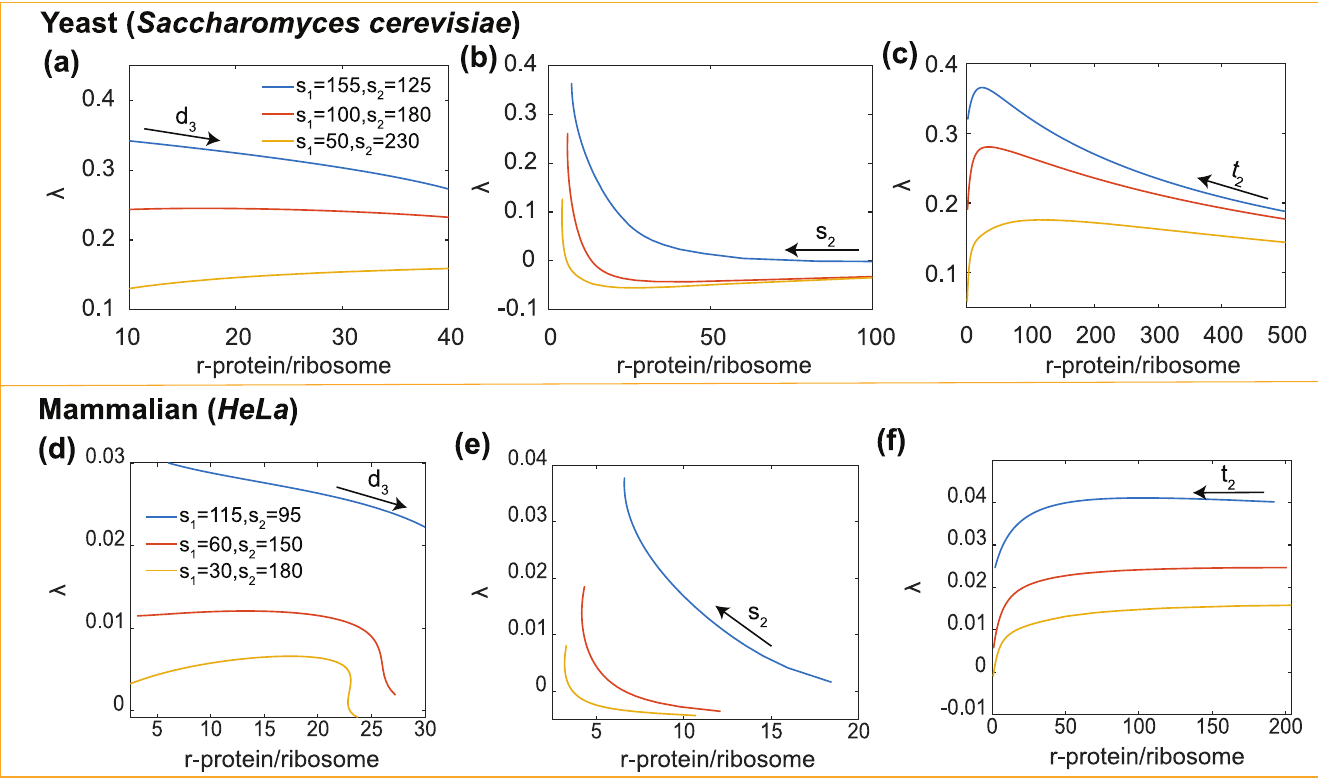
Fig 6. Non-monotonic effects of ribosomal protein to ribosome ratio (RP/R) on growth rate when tuning (a) disassembly coefficient d 3 , (b) ribosome synthesis coefficient s 3 and (c) ribosomal protein synthesis coefficient t 2 . (d)-(f) Corresponding results for mammalian cells. All parameters are listed in Table 2.